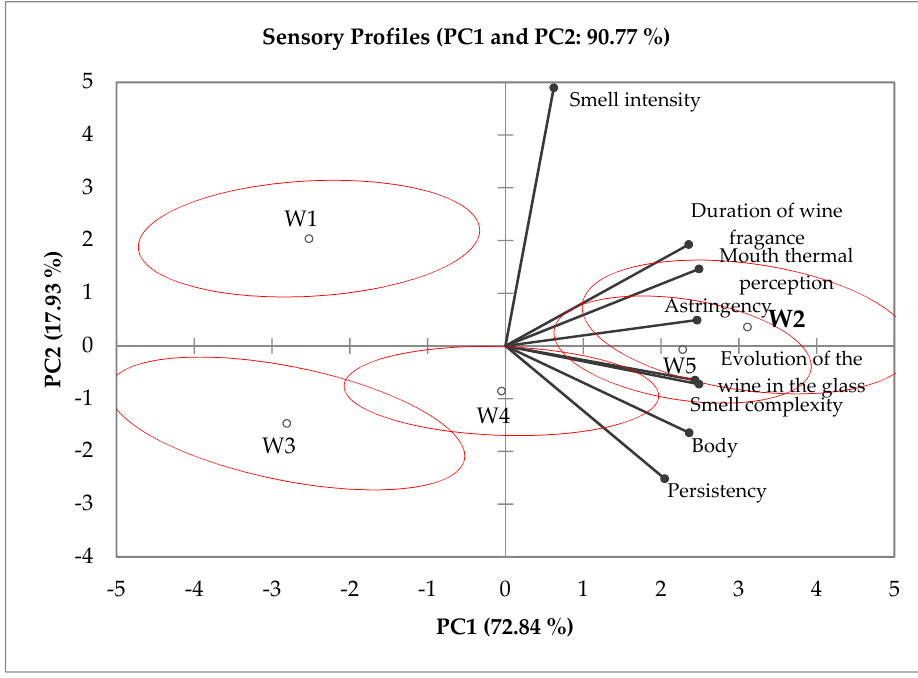
Figure 1. Two-dimensional map made from Principal Component Analysis (PCA) of the sensorial profiles of the white wines (W) obtained by ODP.